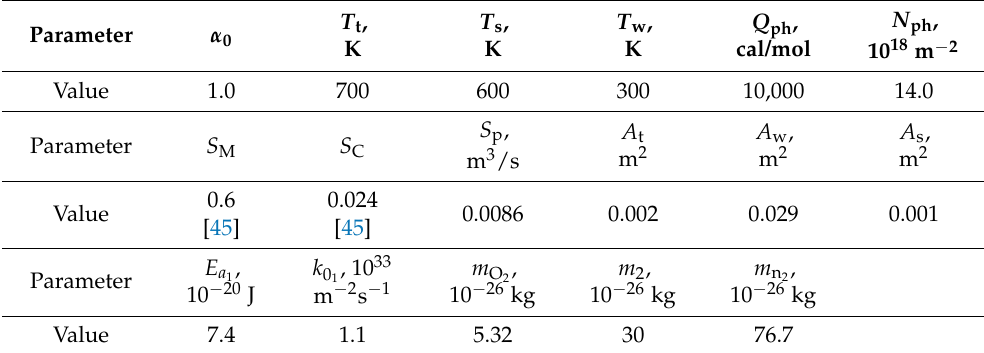
Table 1. The parameters of the model for reactive sputtering of a cold tantalum target in Ar + O 2 . Parameter α